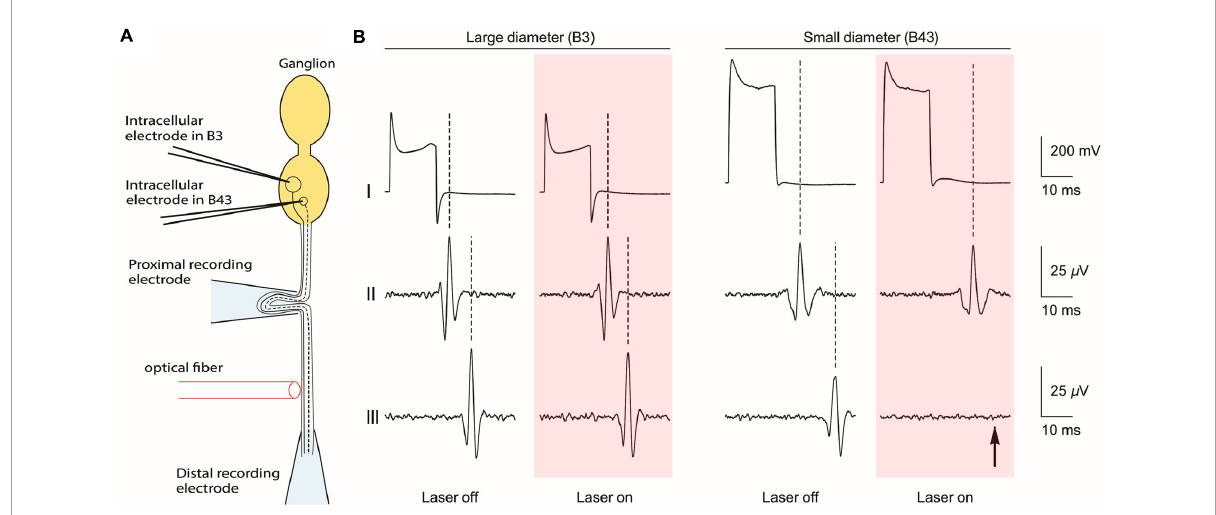
FIGURE3 Direct demonstration of size-selective neural inhibition with B3 and B43 neurons in the Aplysia buccal ganglion. (A) Schematic of the experiment, which is aligned to the traces in part b of the figure. (B) Recordings from the soma (top), proximal recording electrode (middle) and the distal recording electrode (bottom). Pink boxes indicate the time of application of laser light. Intracellular electrical stimulation was applied to a large-diameter neuron (B3) and to a small-diameter neuron (B43), both of which have axons that project through a common nerve. When infrared laser light was applied via an optical fiber that was positioned between two extracellular recording electrodes on the nerve, only the neural conduction on the small-diameter axon was blocked (indicated by arrow). [Reproduced with permission from Lothet et al. (2017).